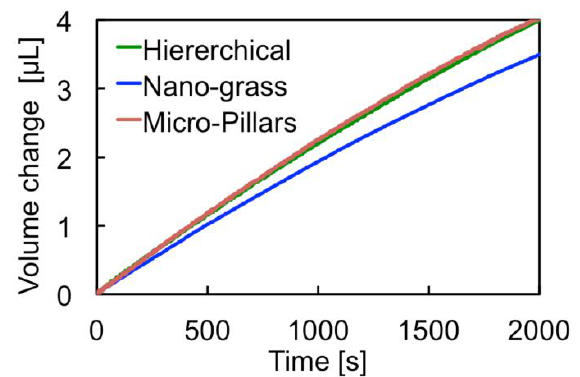
Figure A1. The droplet volume change (evaporated volume) with respect to time. The volume of the droplet pinned on a nano-grass surface decreases slower than that of the droplet resting on the structures with micro-pillars.